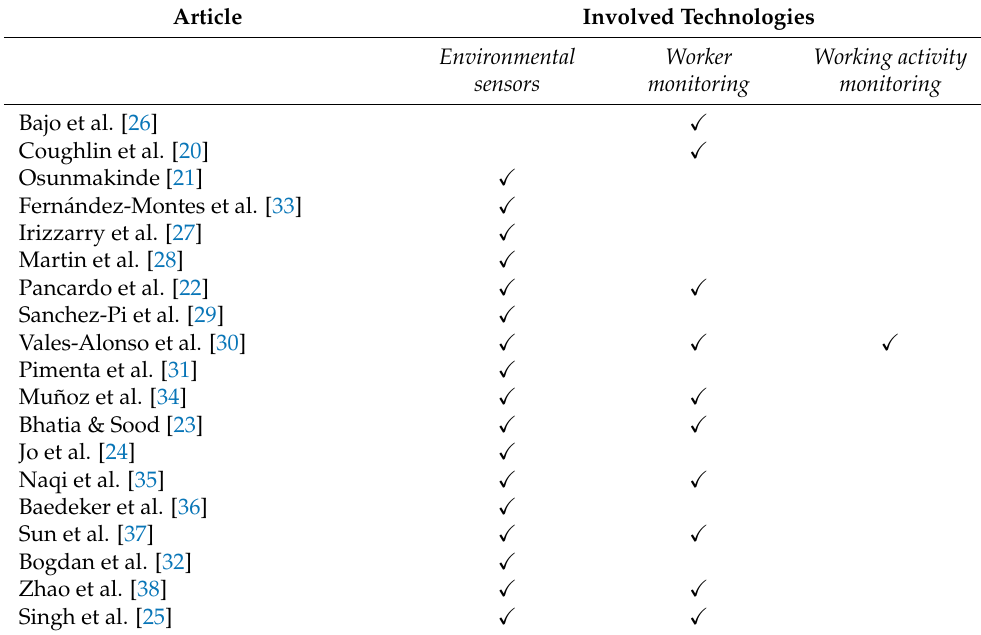
Table 3. Articles clustered according to the type of technologies described in the